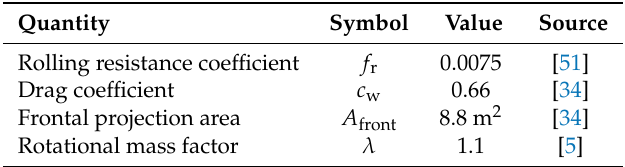
Table 3. Parameters used for longitudinal dynamics